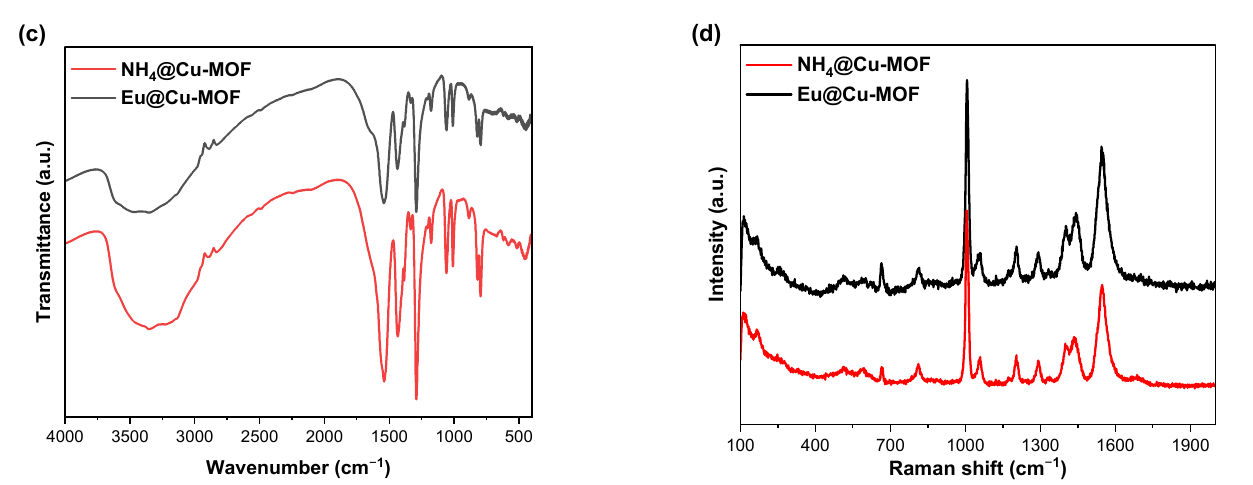
Figure 3. Characterization of Eu@Cu-MOF and NH 4 @Cu-MOF using ( a ) XRD, ( b ) TGA, ( c ) FTIR, and ( d ) Raman spectroscopy.